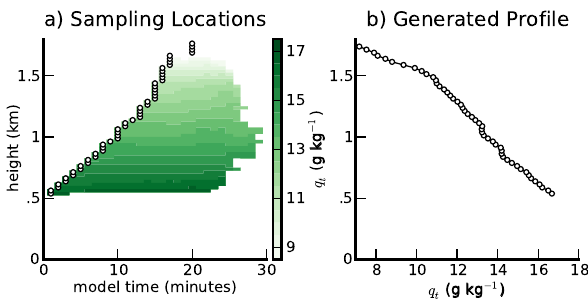
Fig. 14. Method used to generate profiles of environmental prop- erties encountered by a cloud during its initial ascent. (a) At each height, the earliest time the cloud is present is used to sample the mean properties of environmental points directly adjacent to the cloud, and the mean cloud points. (b) These samples are used to generate a profile of the initial properties encountered by the cloud